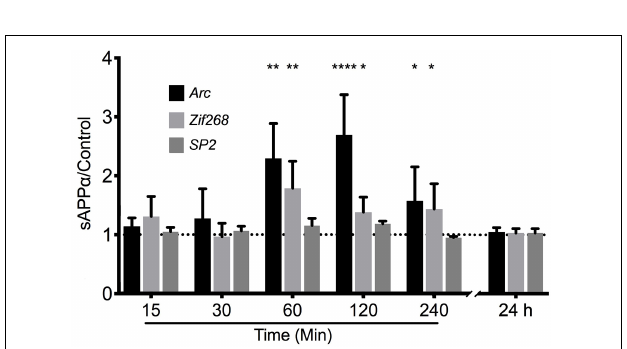
FIGURE 1 | Primary cell cultures display normal expression of cellular and synaptic markers at DIV24-27. (A) Representative immunocytochemistry images of DIV 21-27 neurons show the colocalization of the presynaptic protein synapsin-1 (red) and the postsynaptic AMPA receptor subunit GluA1 (green) with MAP2-positive neurons (magenta) and nuclei (DAPI; blue) (scale bar = 50 µ m). Lower panels show further magnified dendritic compartments (100 µ m) from Synapsin-1 (top), GluA1 (middle) and the colocalization of both (bottom; scale bar = 10 µ m). Primary cell cultures also show populations of (B) GFAP-positive astrocytes (magenta) closely associating with GluA1-positive neurons (green). Inset images show further magnified somatic compartments. (C) Representative electron micrograph showing the presence of synapses between neighboring primary hippocampal cells in culture. Pre- and postsynaptic regions were observed separated by a synaptic cleft. Pre, presynaptic terminal; Post, postsynaptic region; PRs, polyribosomes; PSD, postsynaptic density; SC, synaptic cleft; M, mitochondria. Scale bar = 100 nm.